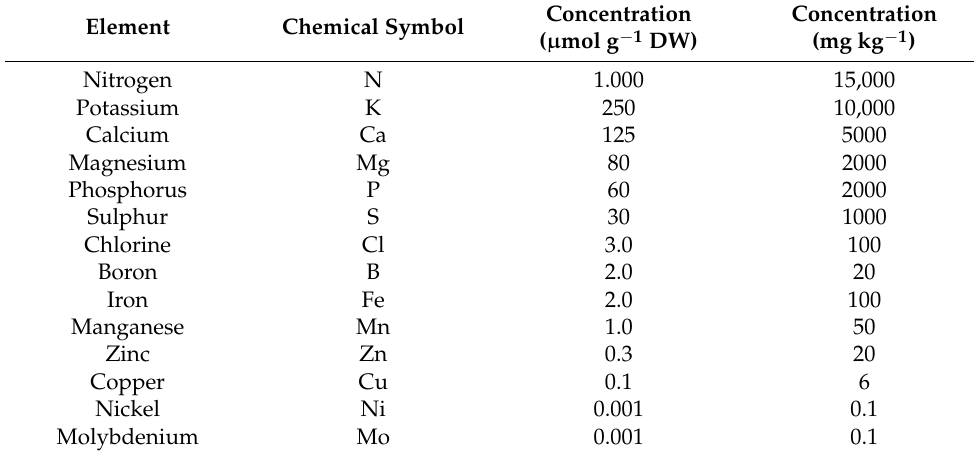
Table 3. Average concentrations of mineral elements in plant shoot dry matter sufficient for adequate growth